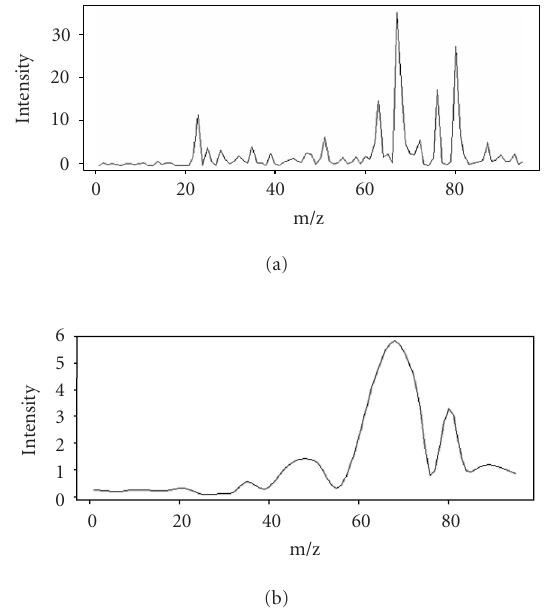
Figure 2. Original curve and a smoothed